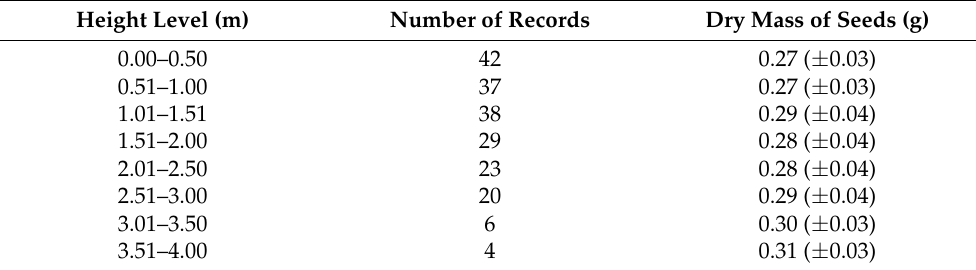
Table 5. The dry weight of 10 seeds (mean ± SD) of Echinocystis lobata (one record) sampled at different height levels in selected study